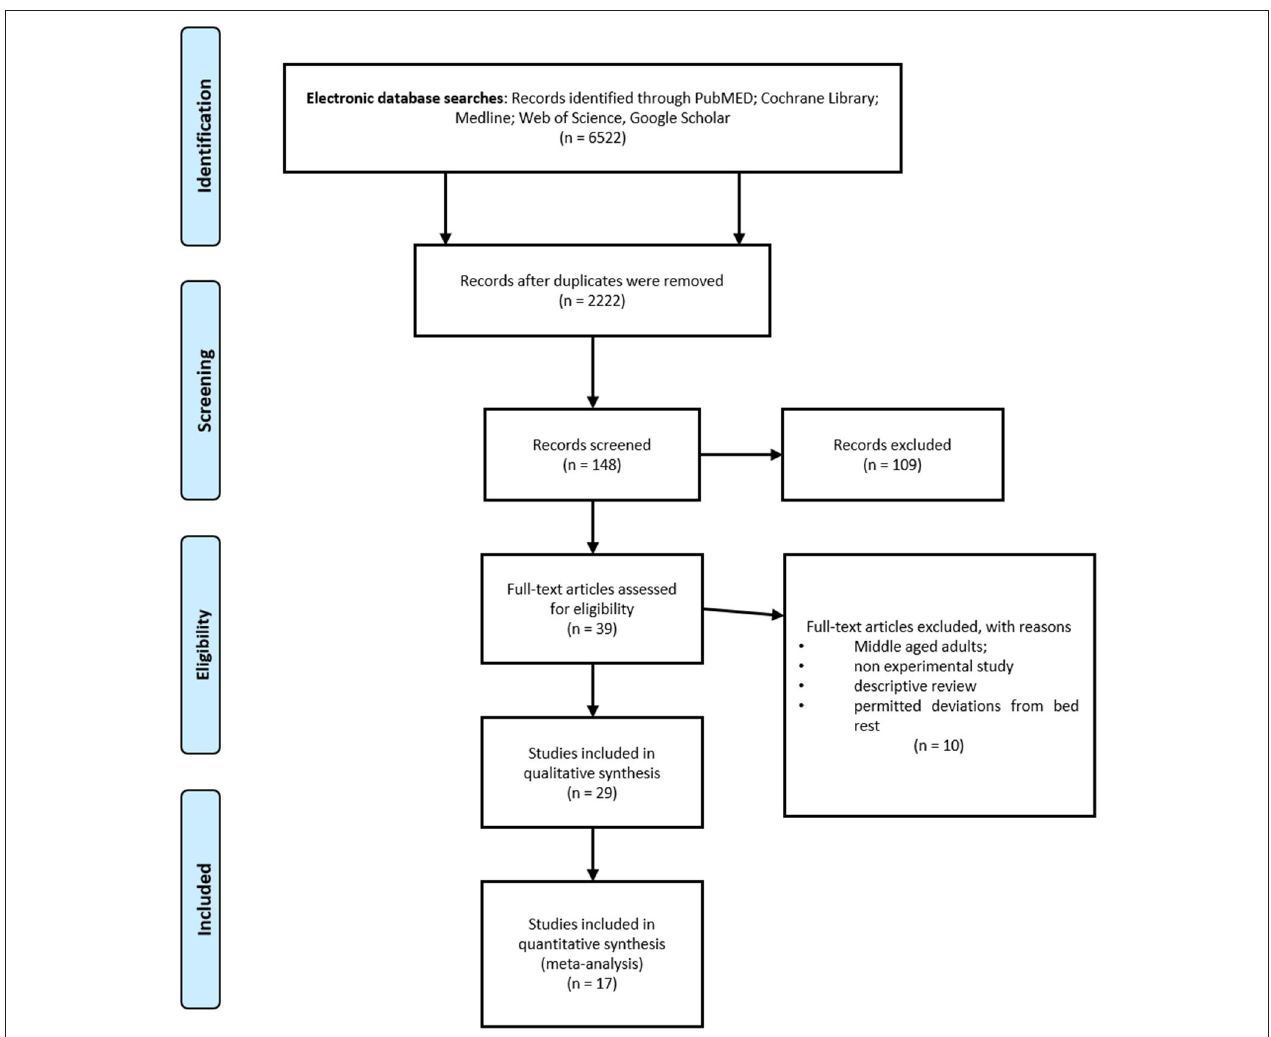
FIGURE 1 | PRISMA flow